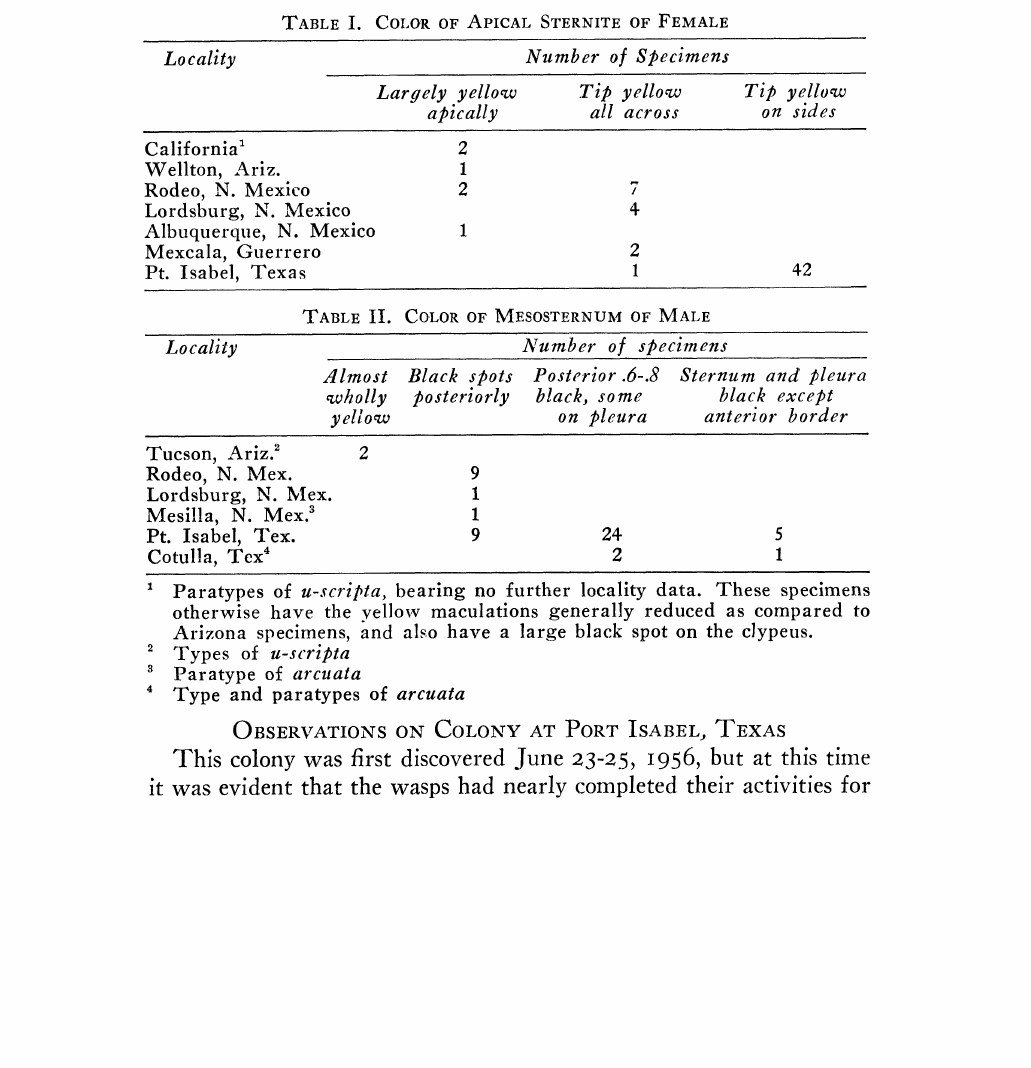
TABLE I. COLOR OV APICAL STERNITE OF FEMALE Locality Number of Specimens Largely yellov Tip yellow Tip yellow: apically all across on sides